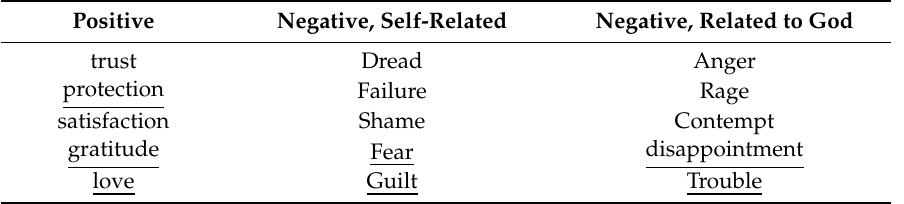
Table 3. Emotions towards